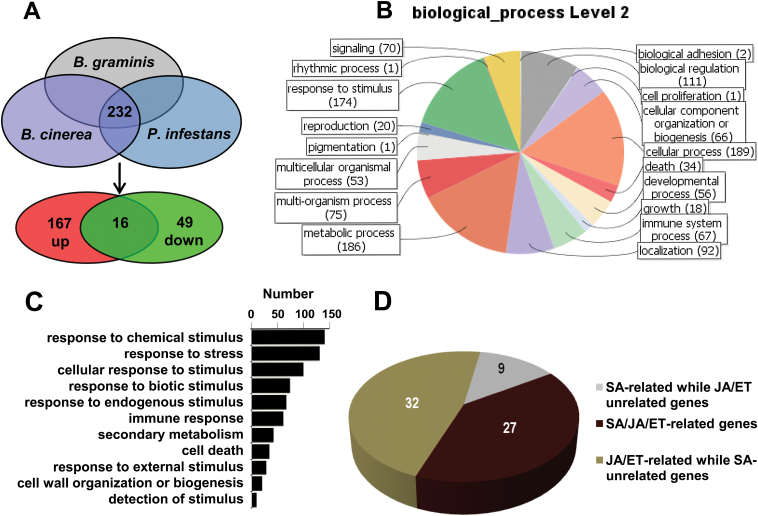
Transcriptomic screening of candidate genes in Arabidopsis performed by Genevestigator and GO categorization. (A) Venn diagrams showing overlap between differentially expressed genes in Arabidopsis in response to B. graminis, B. cinerea and P. infestans infection based on GeneChip. A total of 232 genes were differentially expressed upon inoculation with these three pathogens. A total of 167, 49 and 16 of these 232 genes were upregulated, downregulated and showed complex expression patterns, respectively, upon inoculation with each of these three pathogens. (B) GO categorization of 232 selected Arabidopsis genes at biological process level 2. (C) Partial results of 232 selected genes categorized at biological process level 3. The y- and x-axes refer to defence-related GO categories and numbers of genes, respectively. (D) Number of SA- or JA/ET-related genes among 232 Arabidopsis genes selected according to GO functional analysis at biological process level 6. A colour version of this figure is available at JXB online.